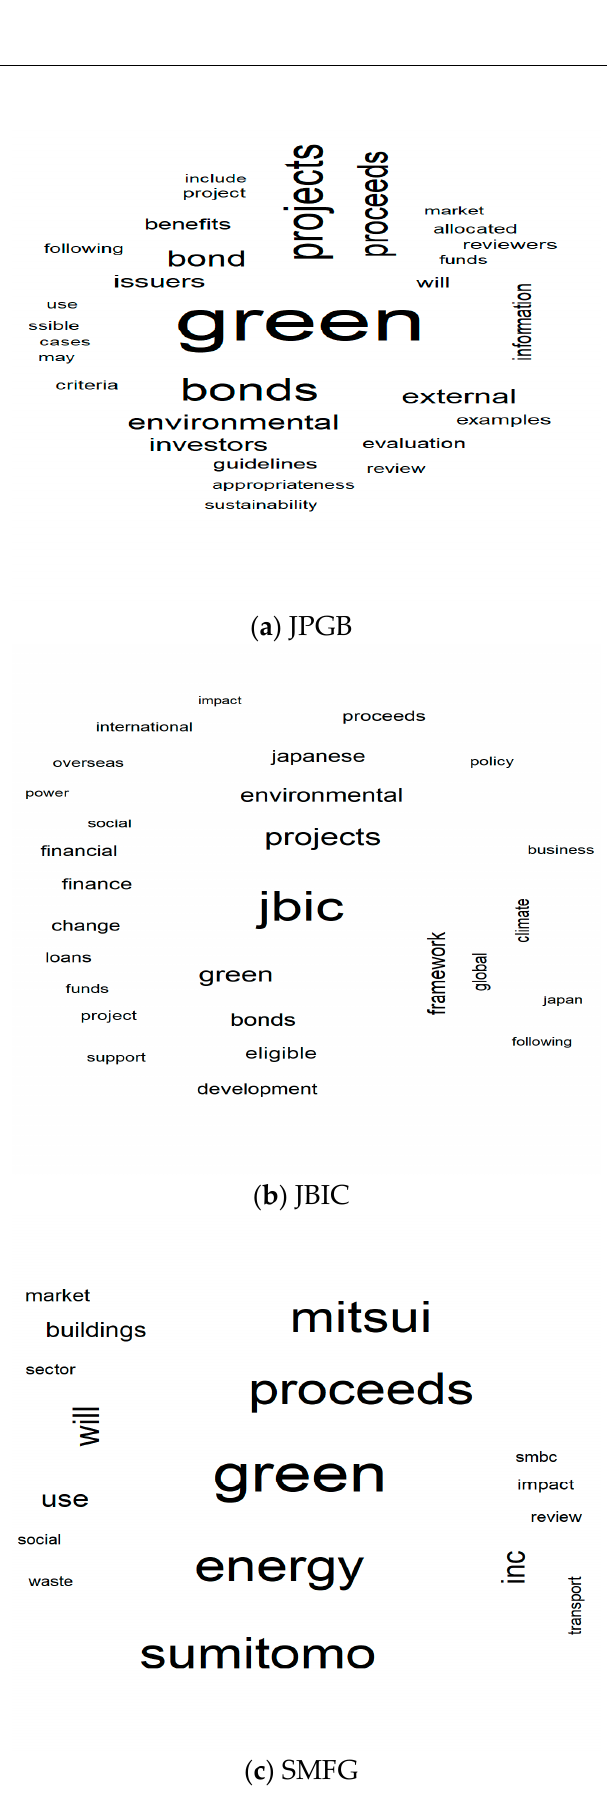
Figure 5. Word cloud results for the Japanese guidelines and frameworks .